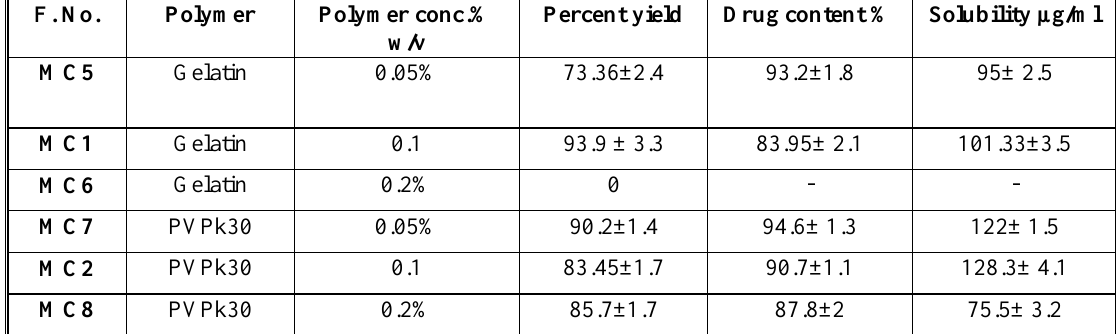
Table (3) Effect of polymer concentration on SM microcrystals formulas F. No.